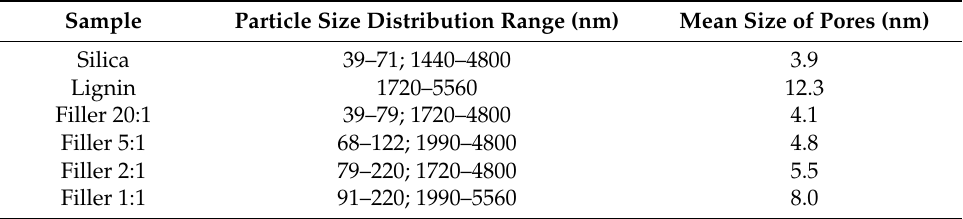
Table 1. Particle size distribution and mean size of pores for hybrid fillers and their